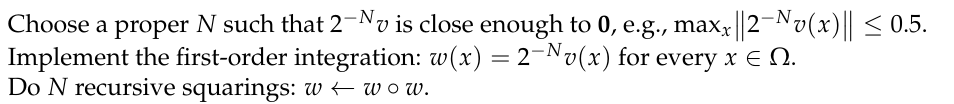
Algorithm 1 The first-order algorithm for the exponential map of vector